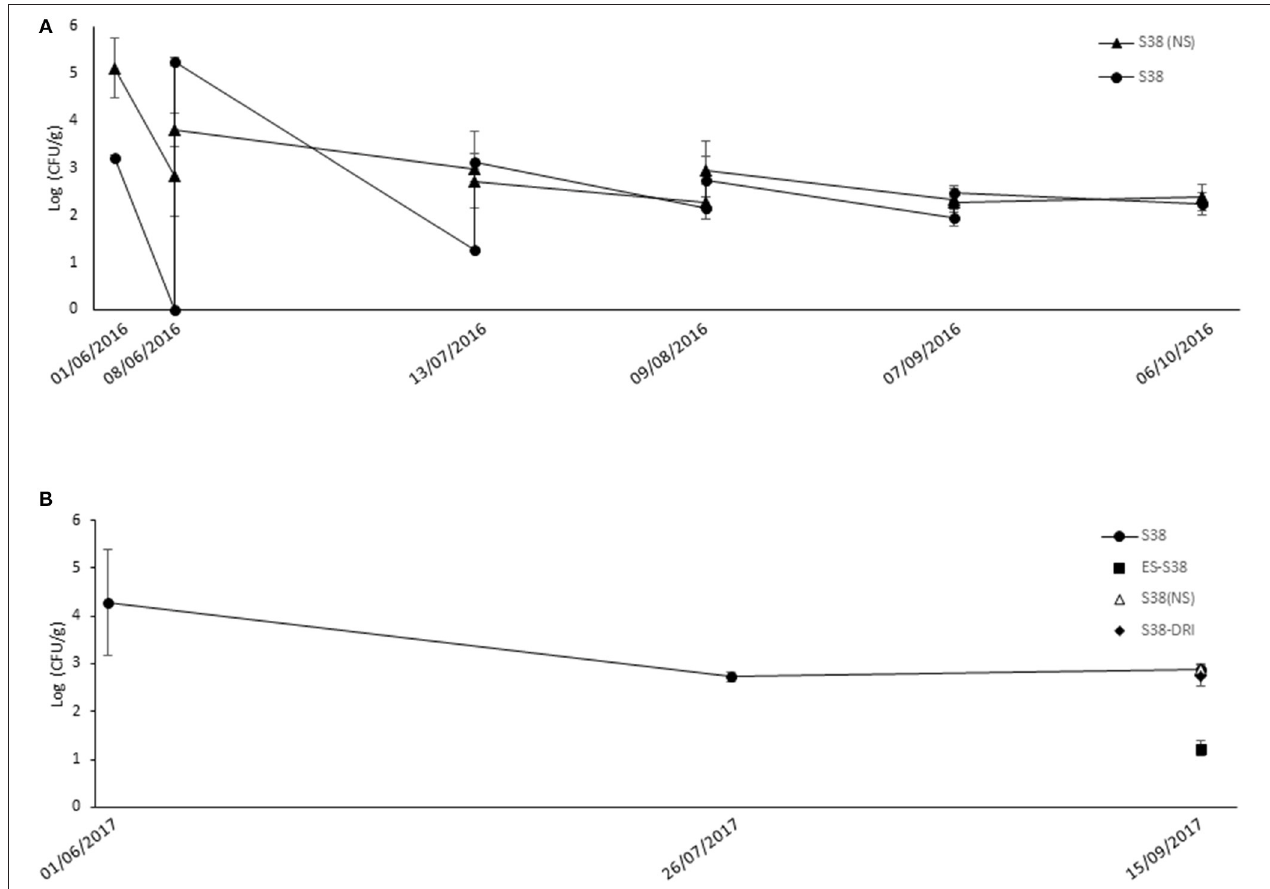
FIGURE 2 | Population dynamics of experimental bacterial strains following spray applications against Botrytis bunch rot in “GF” vineyard. During the 2016 (A) and the 2017 (B) growing season, grapevines cv. Merlot were sprayed with bacterial suspensions of S38 : Bacillus ginsengihumi S38 strain at 5 x 10 7 CFU ml − 1 + Fungicover ® adjuvant at 1 % (v/v); (NS) : Non Supernatant in the bacterial formulation. Applications were carried out at five key phenological stages in the season: Flowering (10 % cap fall); Flowering (100 % cap fall); Pre-bunch closure; 10% Veraison; and 21 days before harvest. ES , “Early Season” strategy, only three applications from flowering to pre-bunch closure; DRI , Applications following a modeled Disease Risk Index used to trigger sprays after veraison (3 applications in 2017). In 2016, samples of flowers and berries for population recovery were collected after and just before each spray application, and at harvest date. In 2016, populations of S38 were assessed after the 100% cap fall and véraison sprays, and at harvest. Populations in the “ES,” “(NS),” and “DRI” treatments were only assessed at harvest. Error bars represent Standard Deviation of the